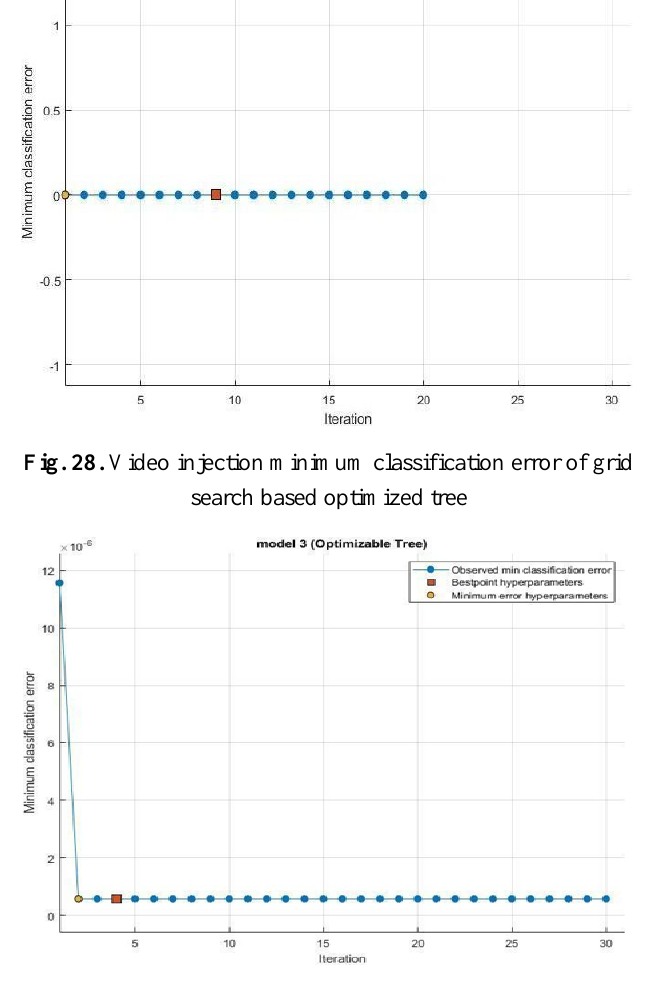
Fig. 29. Video injection minimum classification error of random search based optimized